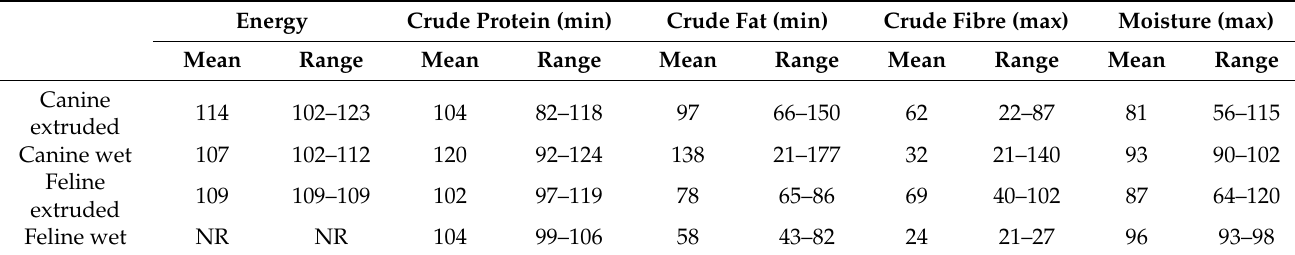
Table 5. Percentage (%) of label guaranteed fulfilled for each nutrient of the guaranteed analysis in plant-based canine and feline foods commercially available in Canada (n =